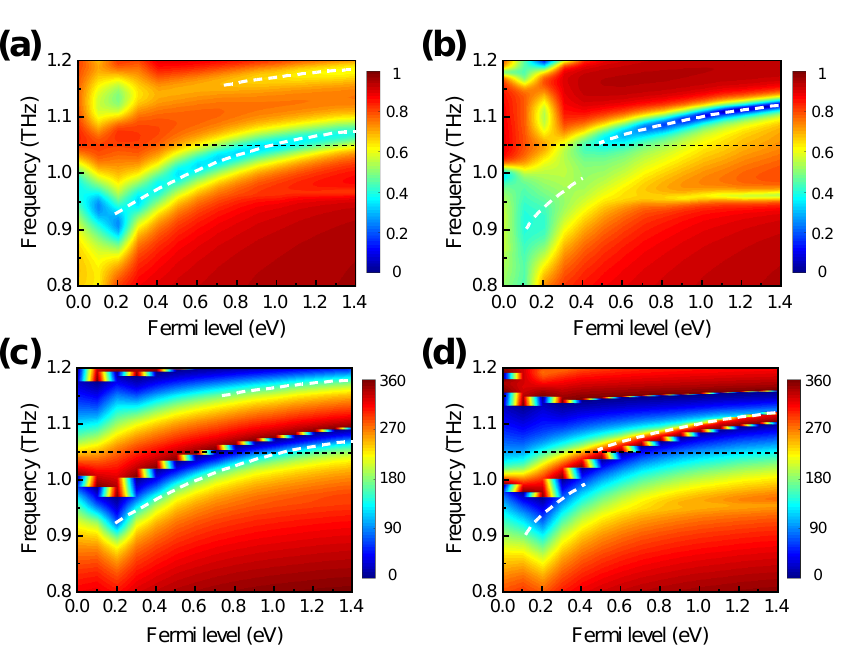
Figure 4. Simulated reflection ( a , b ) amplitude and ( c , d ) phase spectra for different graphene Fermi levels. The calculations were performed with ( a , c ) t = 40 µ m and ( b , d ) t = 50 µ m, respectively.